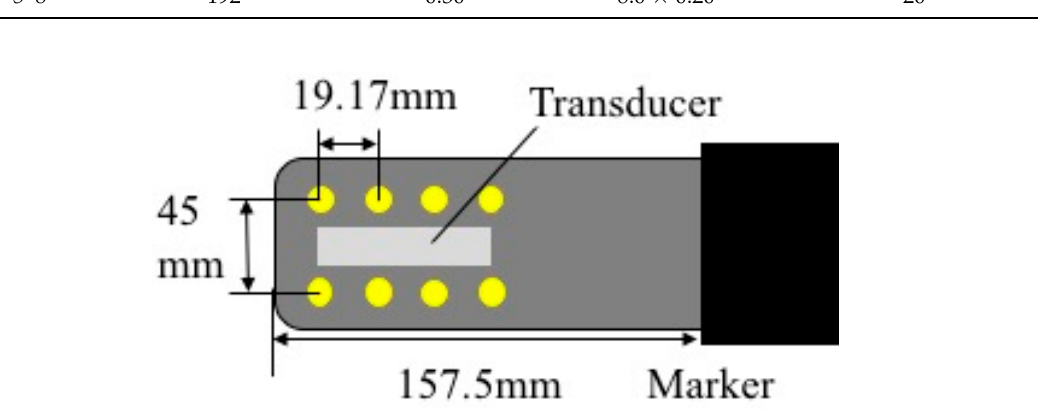
Figure 1. Top view of the prototype ultrasound probe for use in MRI. Array transducers made of 1-3 piezocomposite materials were embedded in the probe (Kyokutan, Japan Probe Co., Yokohama, Japan). The specifications of the array transducers are shown in Table 1. MR-visible fiducial markers were attached to the probe to locate the probe position and orientation in a three-dimensional MRI image.